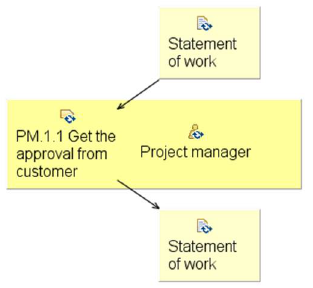
Figure 13. The detailed activity diagram for the PM.1.1 task.